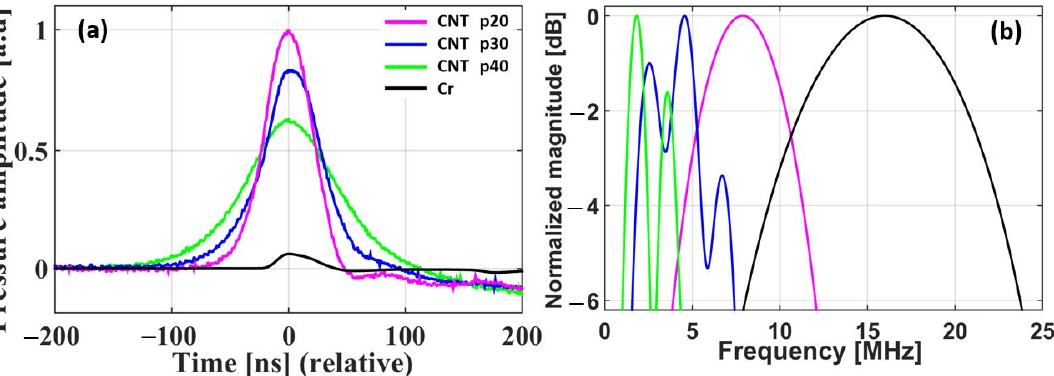
Figure 4. ( a ) Temporal output waveforms and ( b ) their frequency spectra for CNT p20, p30, p40, and Cr film.